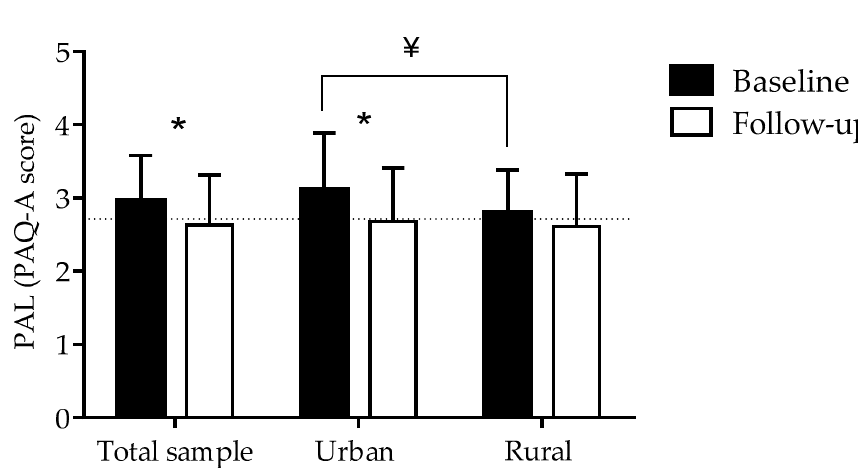
Figure 2. Descriptive statistics for physical activity levels at baseline (before the COVID-19 pandemic), and at follow-up (during the COVID-19 pandemic) with significant t -test differences (¥ indicates significant ( p < 0.05) differences between groups, * indicates significant ( p < 0.05) differences within groups); dotted line presents normal PAL.